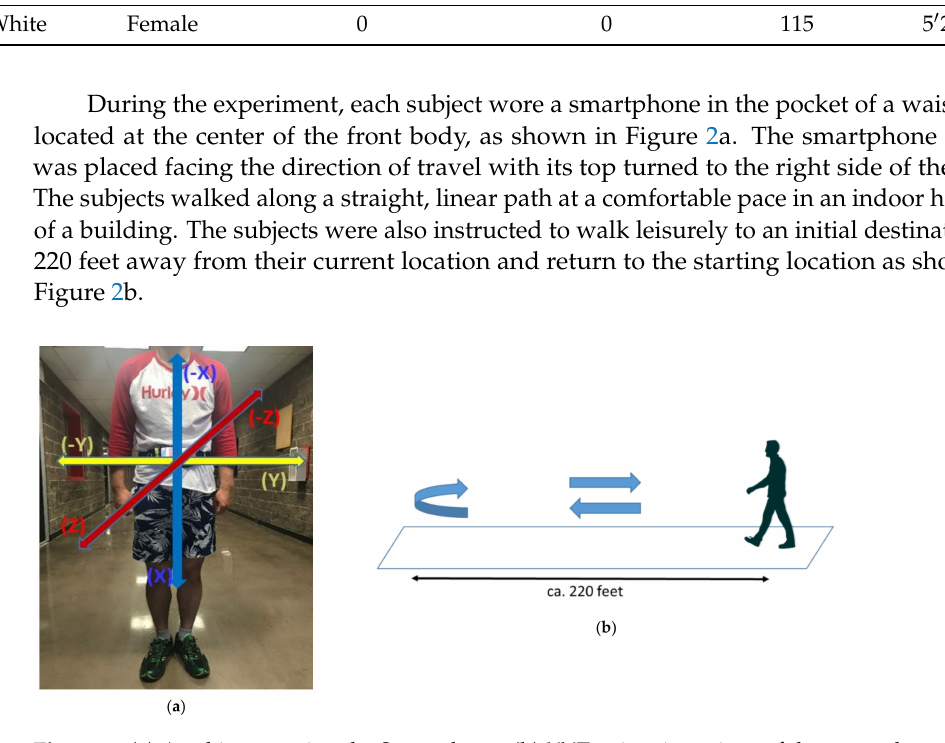
Figure 2. ( a ) A subject wearing the Smartphone. ( b ) XYZ-axis orientations of the smartphone during the walking balance test. X-axis is the right ( − ) and the left (+) side of the subject. Y-axis is the up ( − ) and the down (+) of the subject. Z-axis is the forward (+) and the backward ( − ) of the subject. Subjects wearing the smartphone walked for about 440 feet in